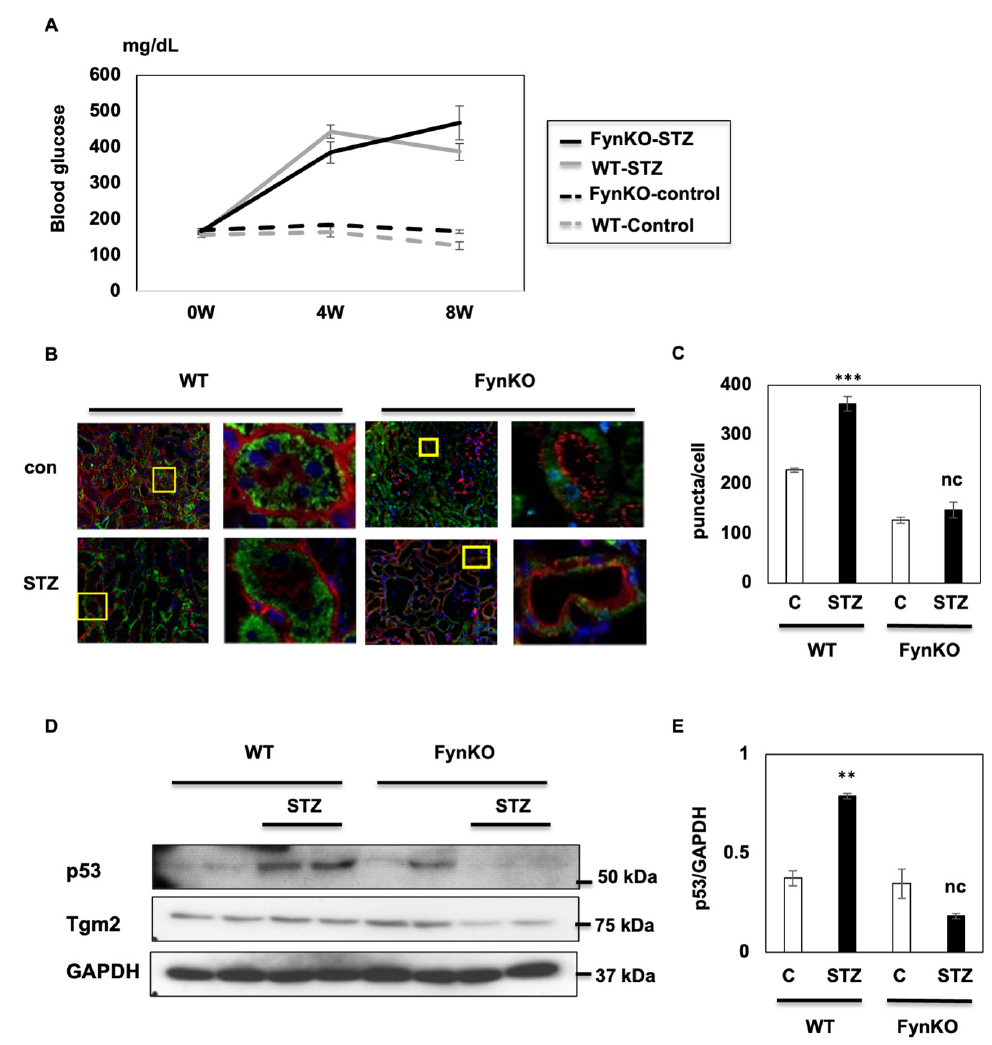
Figure 5. FynKO rescues STZ-induced DKD by inducing autophagy-mediated p53 degradation. ( A ) Fasting blood glucose levels in WT and FynKO mice before and after STZ treatment ( B ) Kidneys were harvested from STZ-treated (and non-treated) FynKO and control mice (WT). Slices were prepared and stained for p62 (green), AQP1 (red), and DAPI (blue). ( C ) Quantification of p62 puncta in each cell described in ( B ). ( D ) p53 protein levels in kidneys of STZ-treated (or not) FynKO and control (WT) mice. These are representative images of three independent experiments. ( E ) p53 expression was normalized to GAPDH. Data are shown as the mean ± s.e.m., ** p < 0.01, *** p < 0.001.